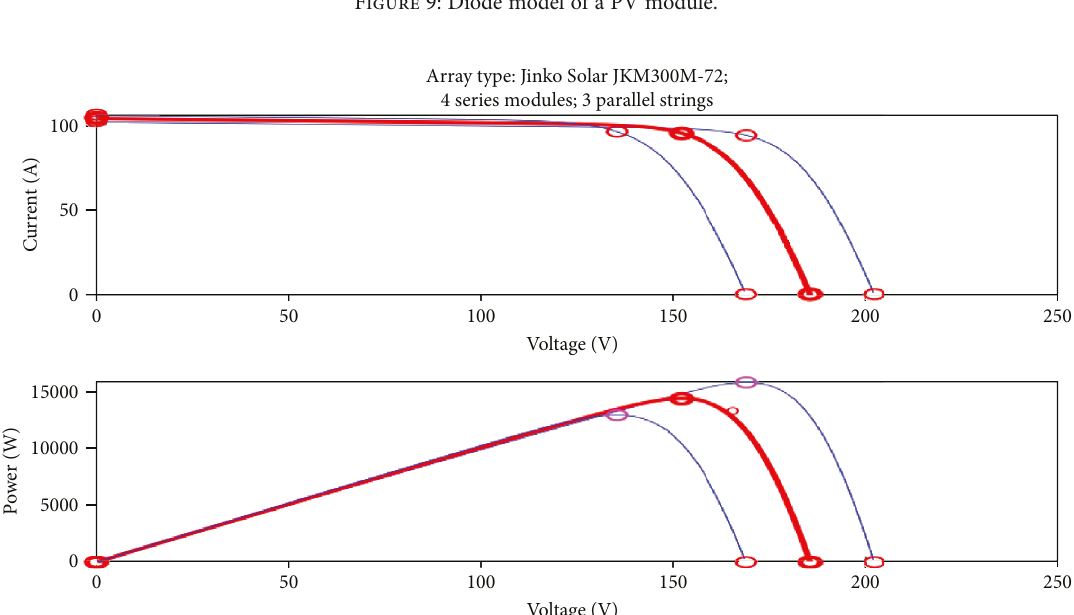
Figure 10: I-V and P-V characteristics of Jinko Solar JMK300M-72 PV array.